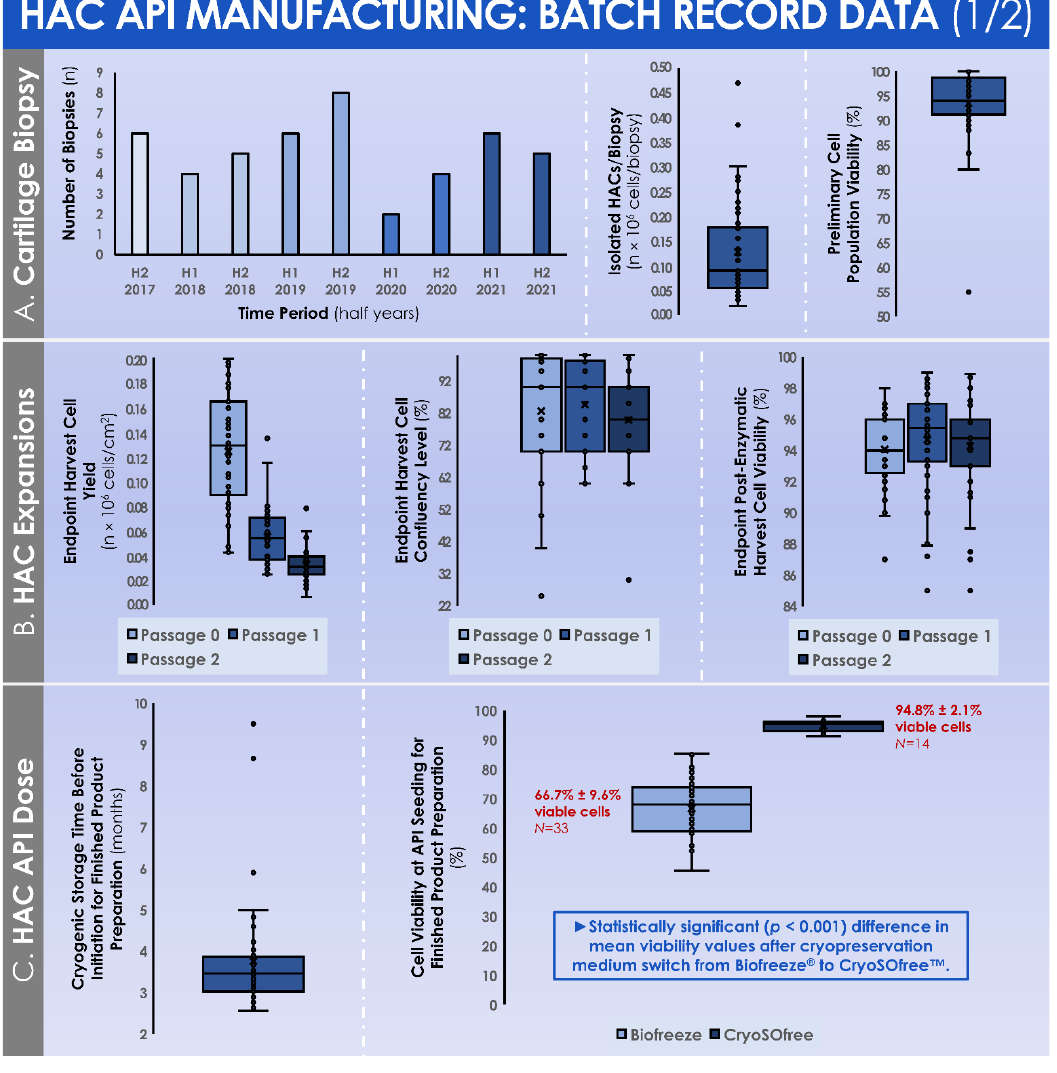
Figure 4. Original data from GMP manufacturing records relative to primary HAC ( n = 47 cell types) isolation and manufacture for human investigational cytotherapeutic use. ( A ) Evolution of the numbers of biopsies performed between 2017 and 2021, quantitative data distribution for the obtained HAC cell counts after enzymatic biopsy processing, and quantitative data distribution for the obtained HAC relative cellular viability after biopsy processing for cell isolation. ( B ) Quantitative data distributions for the manufactured HACs relative to the endpoint harvested cell yields, the endpoint cell confluency levels, and the endpoint post-harvest relative cellular viability levels. ( C ) Quantitative data distributions for the manufactured HACs relative to the storage time-period between cell bank manufacture and finished product preparation, as well as the breakdown of the mean cell viability values at the time of initiation of HACs cryopreserved in Biofreeze ® medium or in CryoSOfree™ medium, respectively. A p -value < 0.05 was retained as a base for statistical significance determination. API, active pharmaceutical ingredient; GMP, good manufacturing practices; HAC, human articular